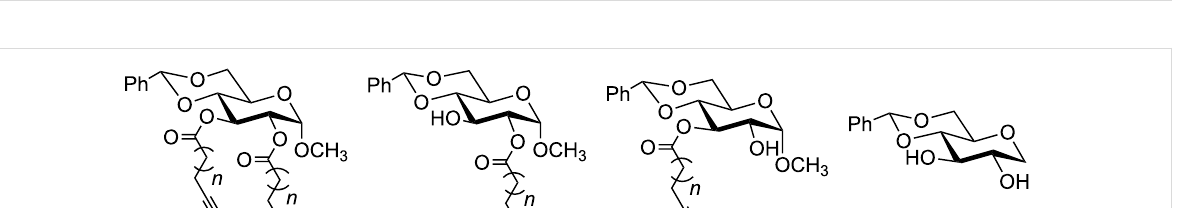
Figure 1: Structures of three ester derivatives of compound 1 .